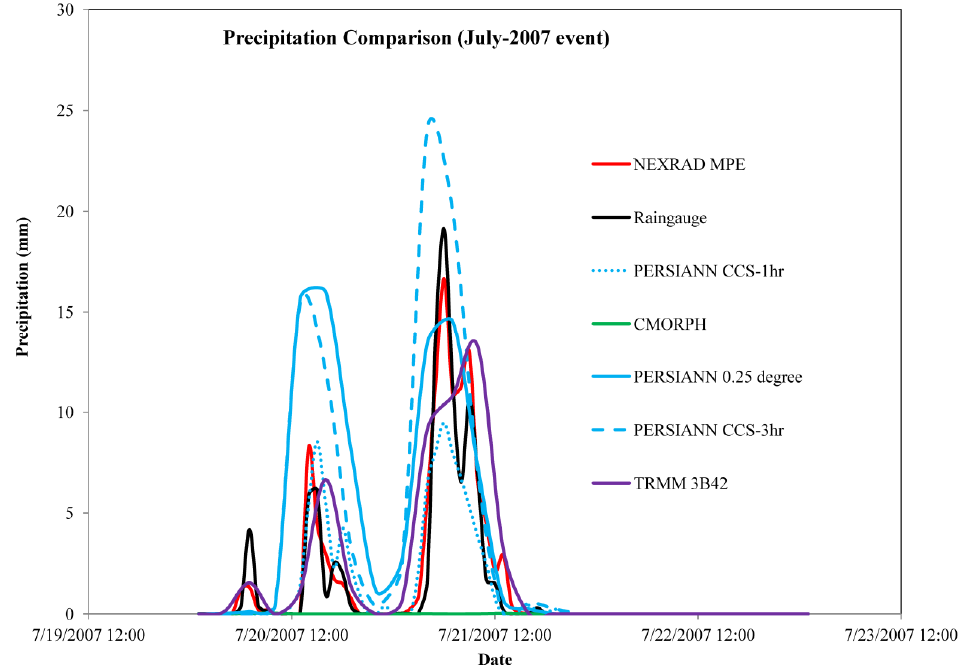
Figure 7. Basin average precipitation comparison for the July 2007 storm